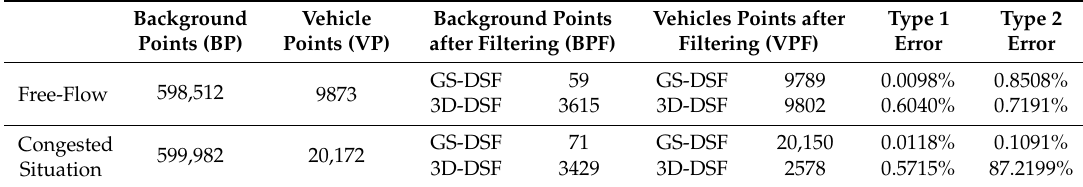
Table 1. Quantitative Evaluation of ground surface-enhanced density statistic filtering (GS-DSF) and 3D density statistic filtering (3D-DSF)